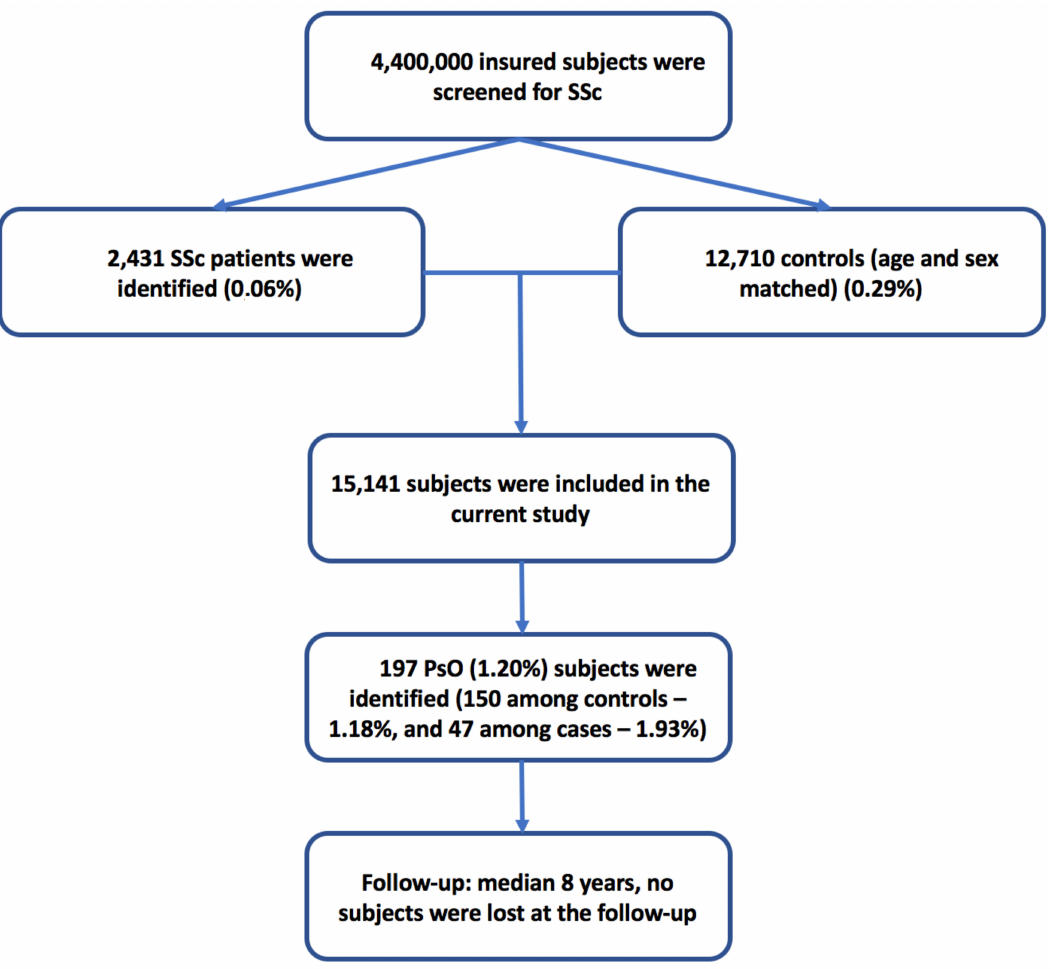
Figure 1. Flowchart of the algorithm of patient selection and inclusion. SSc: systemic sclerosis, PsO: